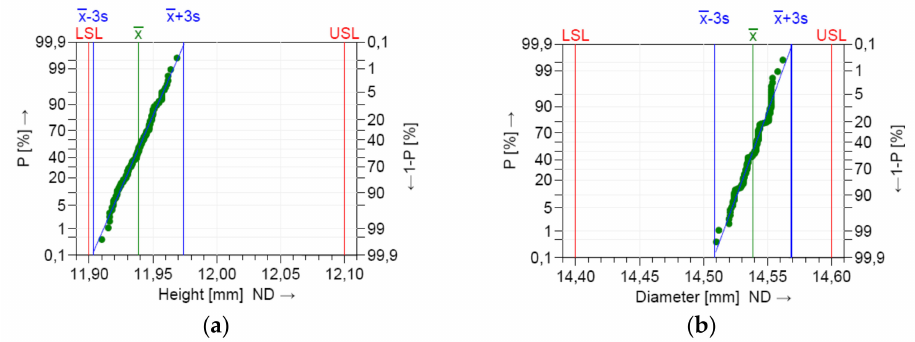
Figure 12. Normal probability plot graph for the long-term capability study: ( a ) height dimension (H); ( b ) diameter dimension (D).